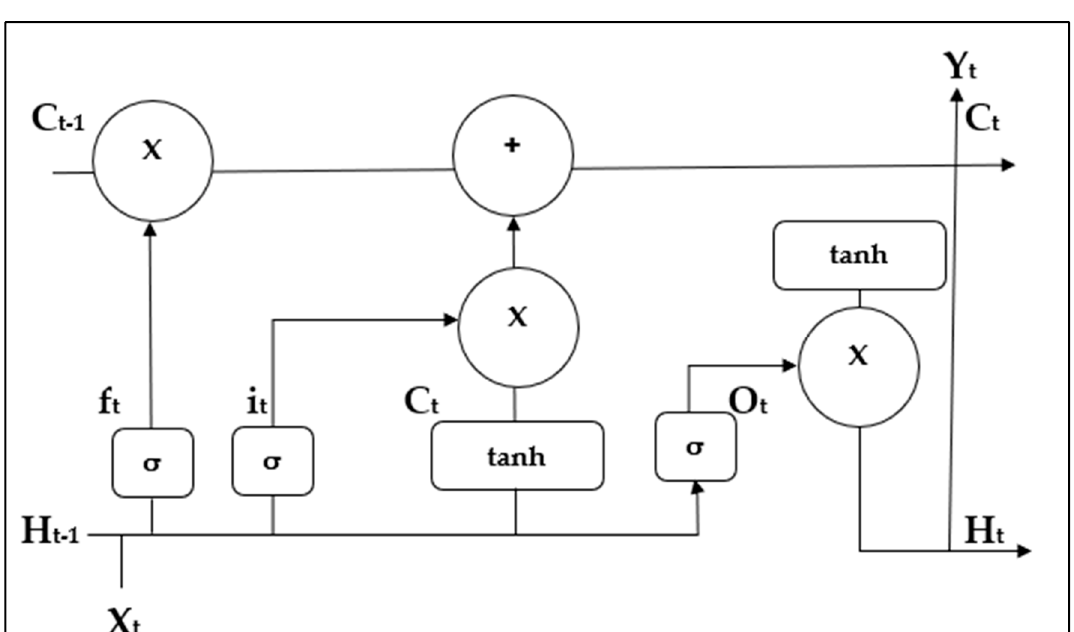
Figure 2. Intuitive diagram of the LSTM [8].